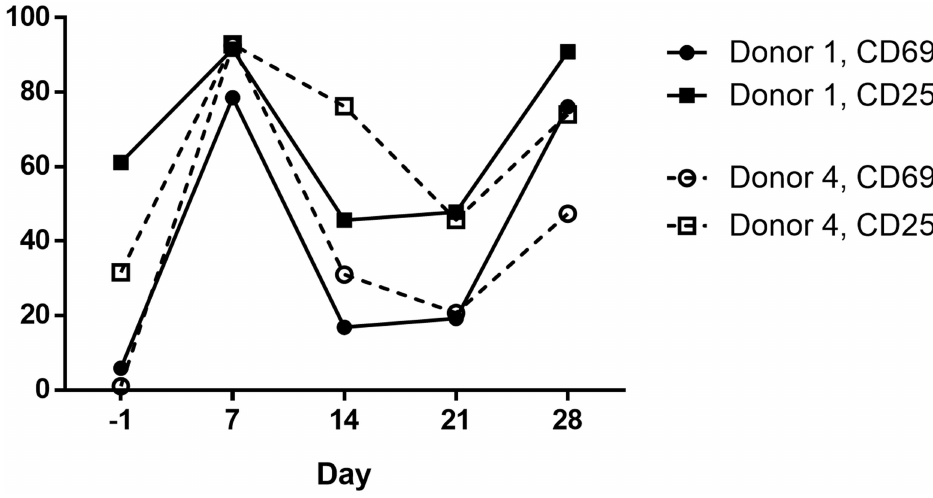
Fig 2. Activation markerexpression during cell culture. The frequencyof CD69 + and CD25 + cells is measuredrelativeto the parent populationof live, CD3 + CD4 +